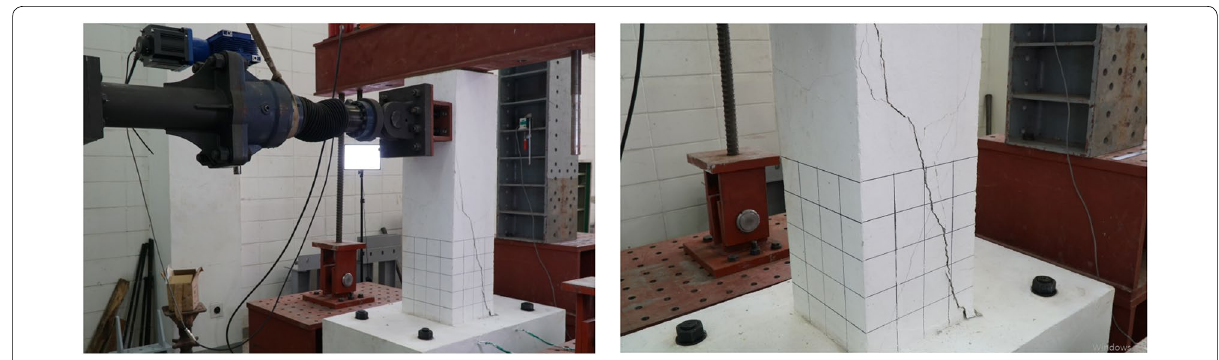
Fig. 14 RC column tests.